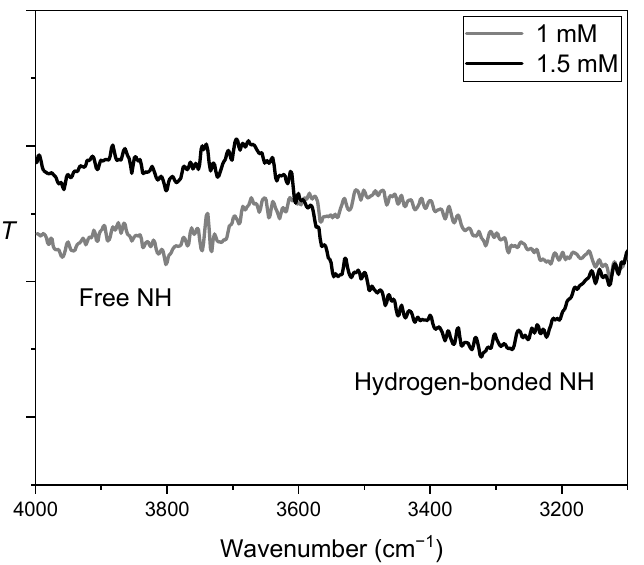
Figure 9. The NH stretching region of the FTIR spectra of 3b in THF at two different concentration (1 mM (grey), 1.5 mM (black)) at 25 °C.